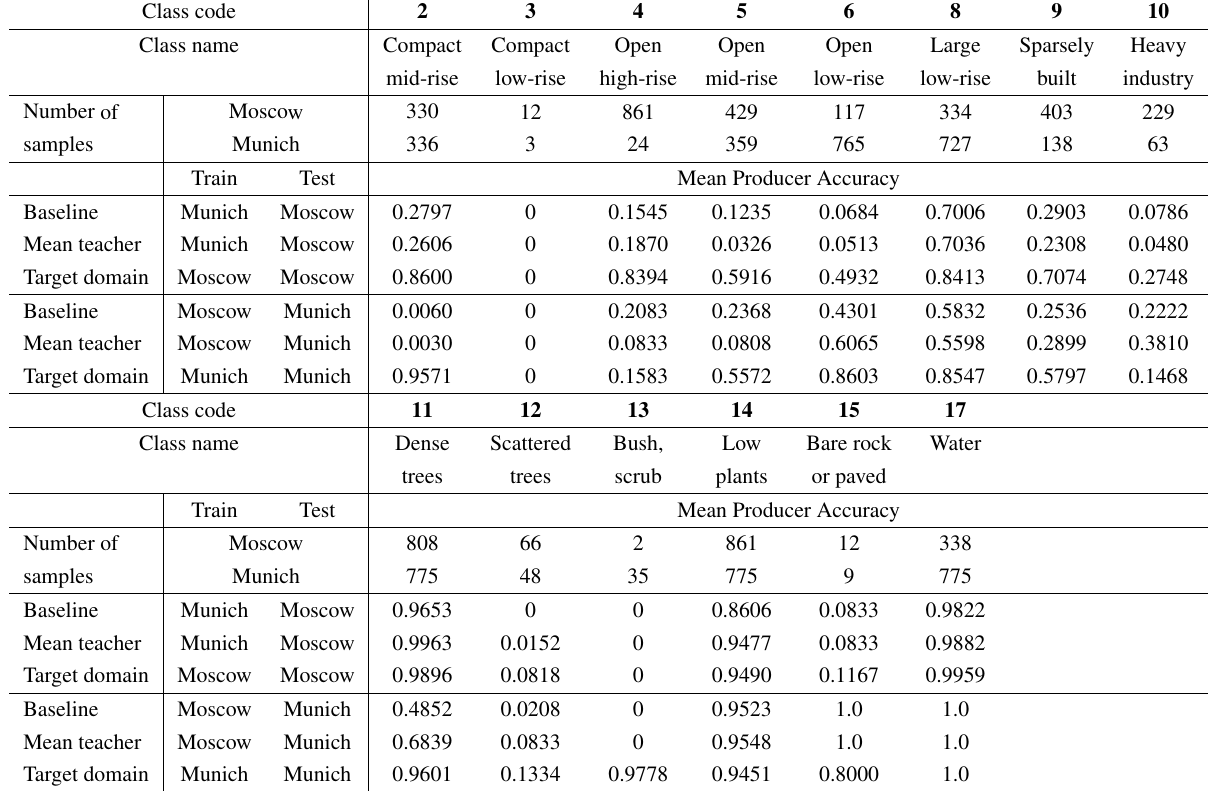
Table 4. The producer accuracy of the baseline network and the mean teacher model. The numbers are the mean value of ten independent